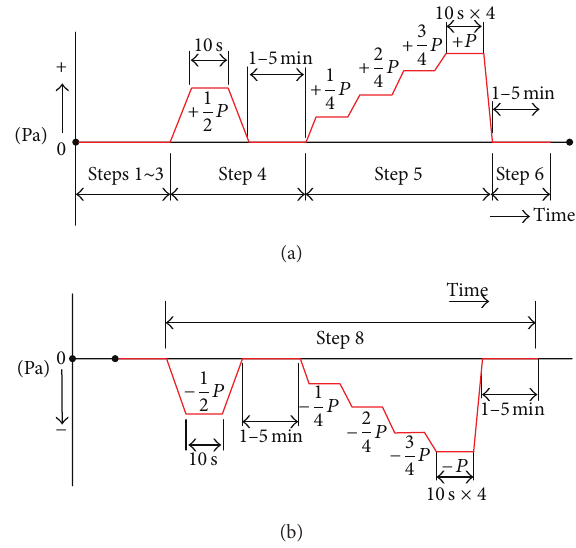
Figure 3: (a) Positive wind pressure intervals and (b) negative wind pressure intervals for wind resistance